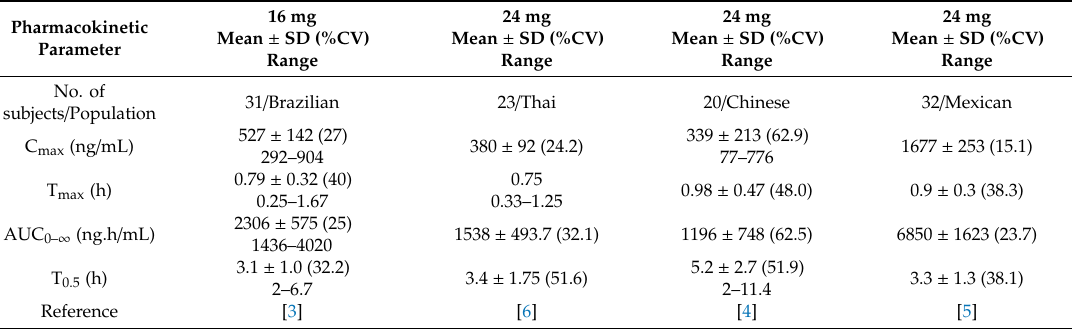
Table 3. Pharmacokinetic parameters of 2-pyridyl acetic acid as assessed in previous investigations after administration of single doses of 16 and 24 mg betahistine to healthy adult fasted